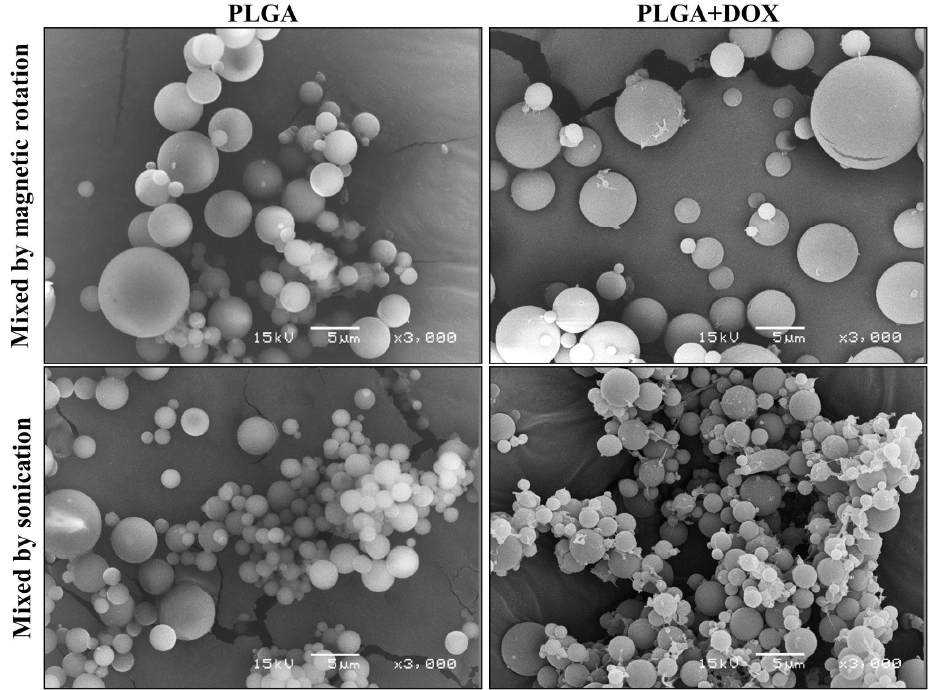
Figure 3. PLGA and PLGA + DOX microspheres observed by scanning electron microscopy. Bars 5 µm.